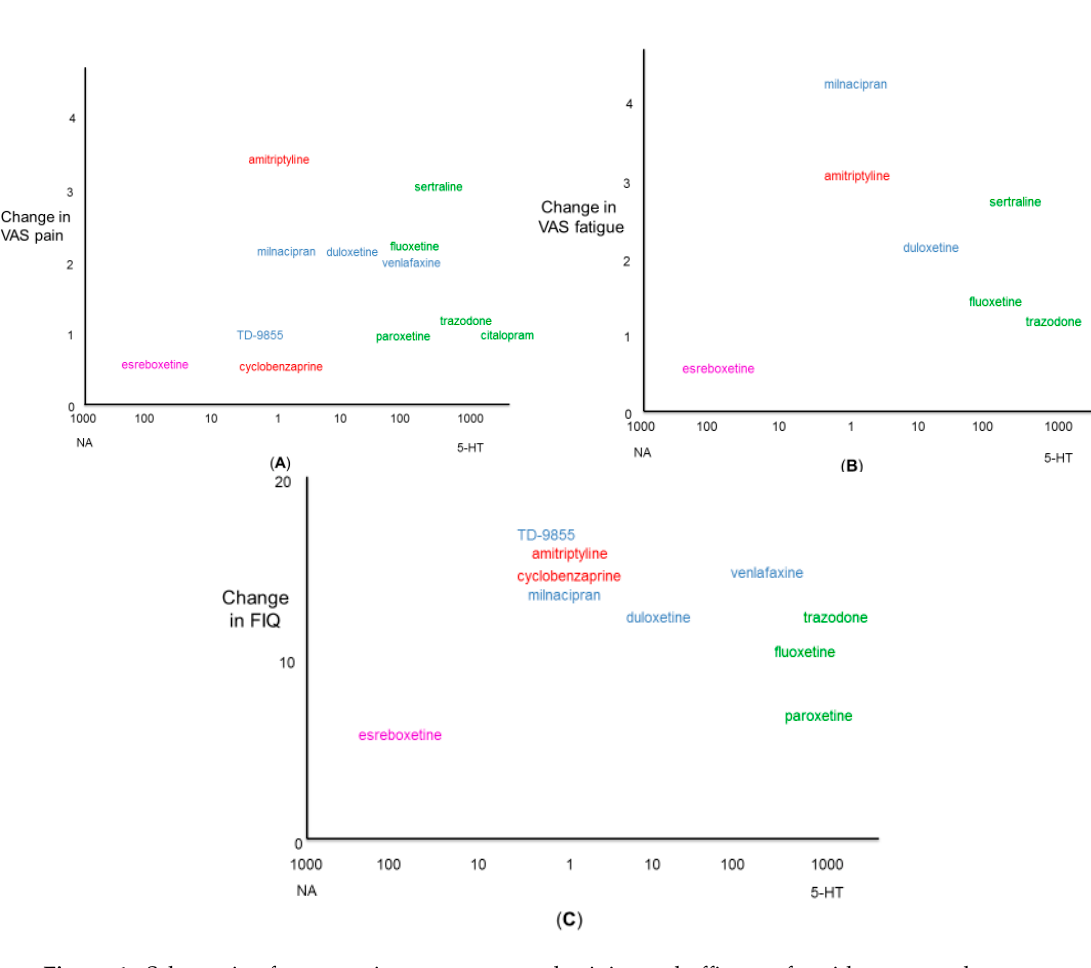
Figure 1. Schematic of monoamine transporter selectivity and efficacy of antidepressant drugs to reduce pain ( A ), fatigue ( B ) and Fibromyalgia Impact Questionnaire (FIQ) score ( C ) in patients with fibromyalgia. Selectivity ratios for the antidepressant drugs were determined from affinity and inhibitory properties for noradrenaline reuptake transporter (NET) and serotonin reuptake transporter (SERT) where NA indicates a selectivity for NET over SERT values and 5-HT indicates a selectivity for SERT over NET (see Table 1). Pain measurement ( A ) is presented as change on a 0–10 scale visual analogue scale (VAS); fatigue measurement ( B ) is presented as change on a 0–10 scale VAS; FIQ score ( C ) is presented as a change on a 0–100 scale (see Table 2). TCAs are indicated in red, SNRIs in blue, SSRIs in green and NRIs in purple.